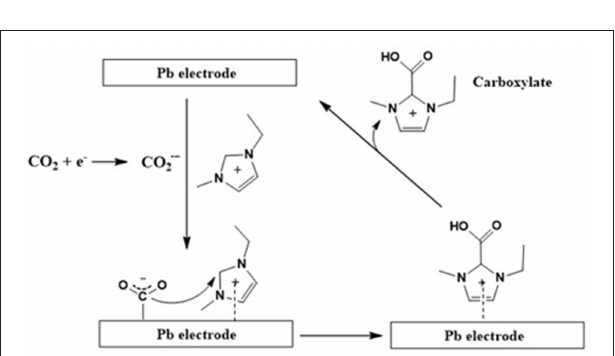
FIGURE 3 | The electrochemical reduction pathway for CO 2 to CO at Pd electrode in [emim][Tf 2 N]/acetonitrile (CO formation). Adopted from Sun et al. (2014) .